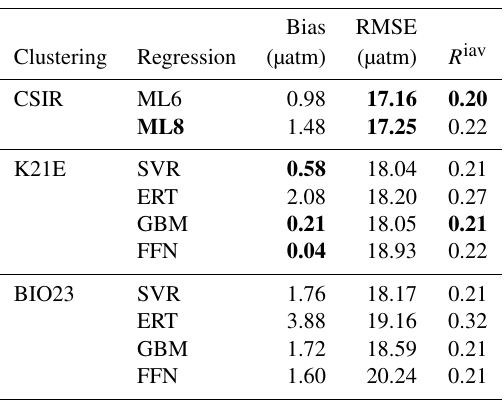
Table 4. The robust estimates of bias, RMSE and R iav from 1982 to 2016 for BIO23, K21E and the ensemble averages, CSIR-ML6 and CSIR-ML8, where the first excludes the ERT method. Bold values are significantly lower than the mean for that column ( p < 0 . 05 for the two-tailed Z test; absolute values are used for the bias column). See Table S1 for further comparisons between different ensemble average configurations.